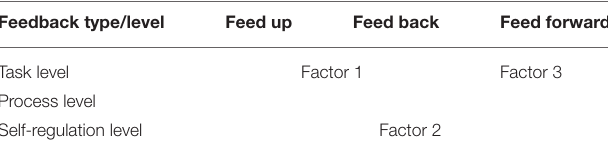
TABLE 2 | The structure of the 3 factor exploratory factor analysis in relation to the conceptual model of